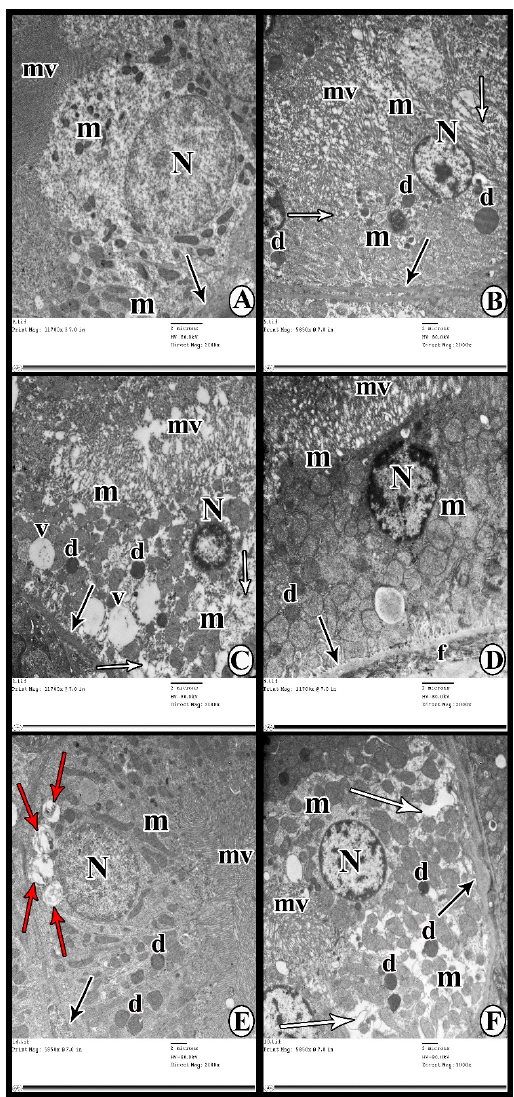
Figure 8. Ultrathin sections showing proximal tubular cells of ( A ) Group I resting on a thin regular basement membrane (thin arrow). Apical microvilli (mv) are numerous and tightly packed. The nucleus (N) appears oval and euchromatic, and the cytoplasm contains numerous mitochondria (m). ( B ) Group IIa shows a slightly thickened tubular basement membrane (thin arrow), swollen disrupted apical microvilli (mv), and a shrunken nucleus (N). The cytoplasm shows areas of rarefaction (white arrows), numerous swollen mitochondria (m), and scattered electron-dense bodies (d). ( C ) Group IIb shows increased thickening of the tubular basement membrane (thin arrow), disrupted apical microvilli (mv), and a shrunken heterochromatic nucleus (N). The cytoplasm shows multiple variably sized vacuoles (v), variably sized mitochondria (m), and few scattered electron-dense bodies (d). ( D ) Group III shows a tubular cell resting on thickened basement membrane (thin arrow). Apical microvilli (mv) appear swollen and distorted. The nucleus (N) shows clumps of heterochromatin. The cytoplasm contains numerous swollen mitochondria (m) of various shapes and sizes. A small electron-dense body (d) is also observed. Thin collagen fibrils (f) are seen in the interstitium. ( E ) Group IV shows proximal tubular cells resting on a thin basement membrane (thin arrow). The apical microvilli (mv) appear numerous and tightly packed, and the nucleus (N) is round and euchromatic. The cytoplasm contains numerous autophagosomes (red arrows) containing cellular debris, numerous scattered electron-dense bodies (d), and elongated mitochondria (m). ( F ) Group V shows persistent thickening of the tubular basement membrane in some areas (thin arrow), swollen apical microvilli (mv), and slightly shrunken nucleus (N). The cytoplasm shows areas of rarefication (white arrows), variably sized mitochondria (m), and scattered electron-dense bodies